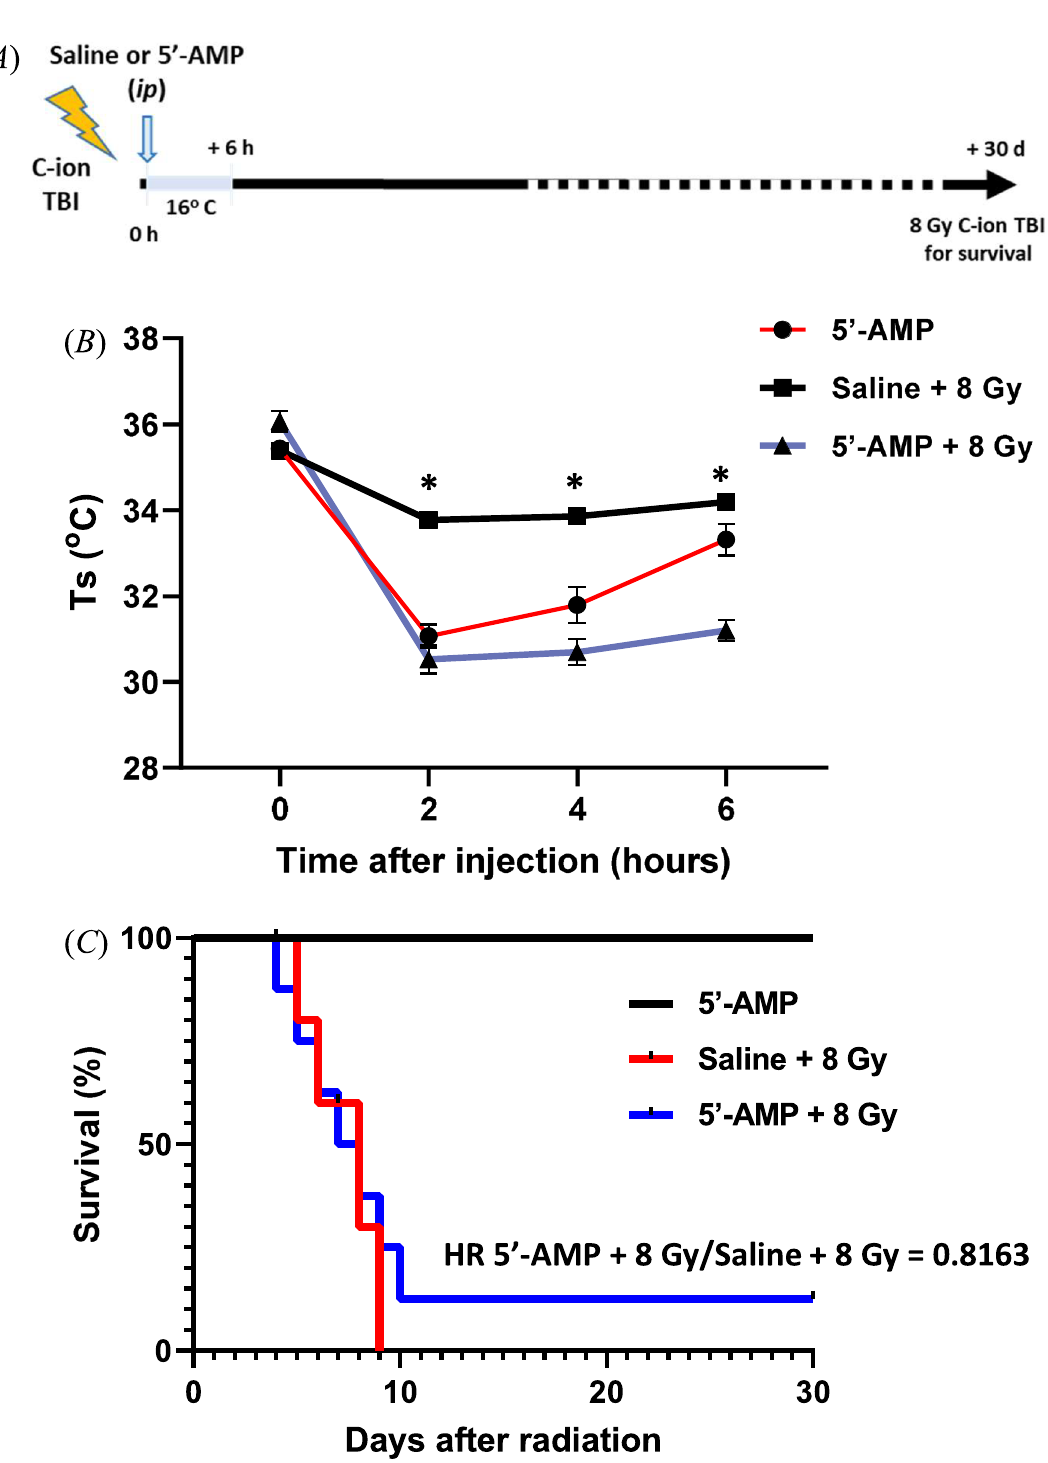
Figure 1. Synthetic hibernation induction in rats. ( A ) Experimental setup for radiation, hypothermia induction, and analysis. Total body irradiation (TBI). ( B ) The 5 ′ -AMP administration, in combination with a low ambient temperature (Ta 16 °C), decreased their skin temperature (Ts) up to a moderate level of 27–32.9 °C (± 0.1–0.58) and ( C ) survival following 8 Gy C-ion whole-body irradiation, Hazard ratio (HR). Data are presented as the mean SEM. * P < 0.05 (Saline vs. 5 ′